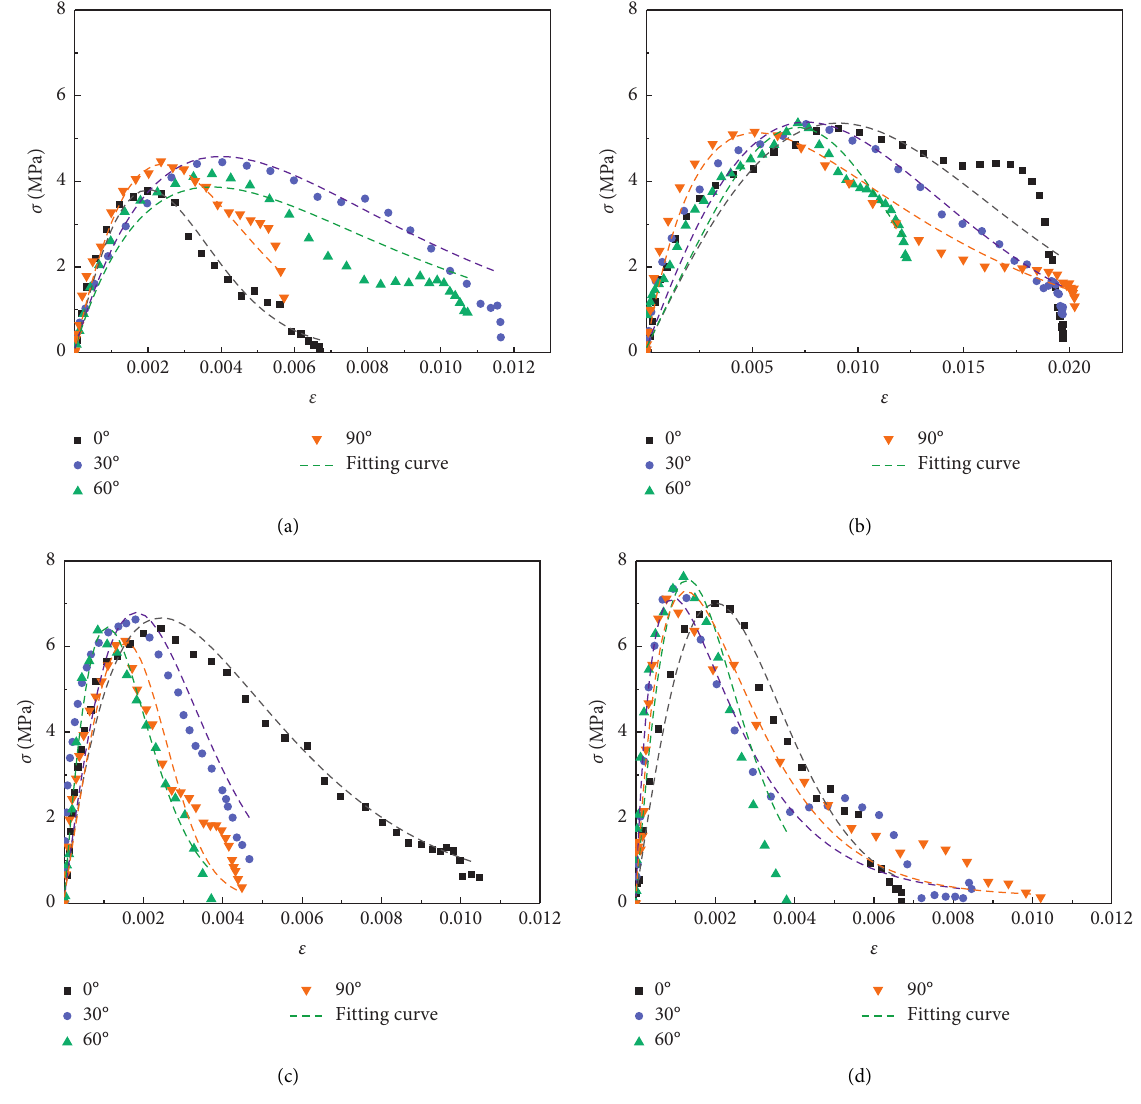
Figure 9: Fitting curve of the constitutive equation. (a) T � − 5 ℃ . (b) T � − 10 ℃ . (c) T � − 15 ℃ . (d). T � − 20 ℃